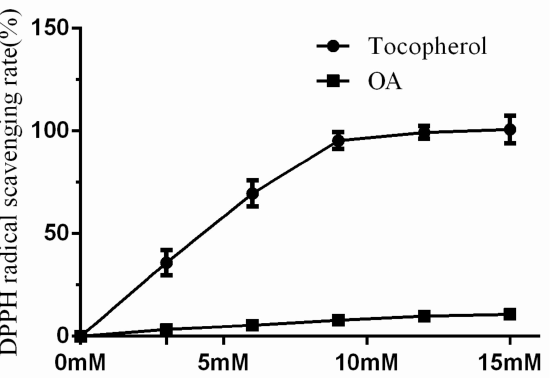
Figure 4. The DPPH radical scavenging test of Obcordata A (OA), investigates the dose–e ff ect relationship of OA scavenging DPPH free radicals and judge its direct antioxidant activity. n = 3 independent